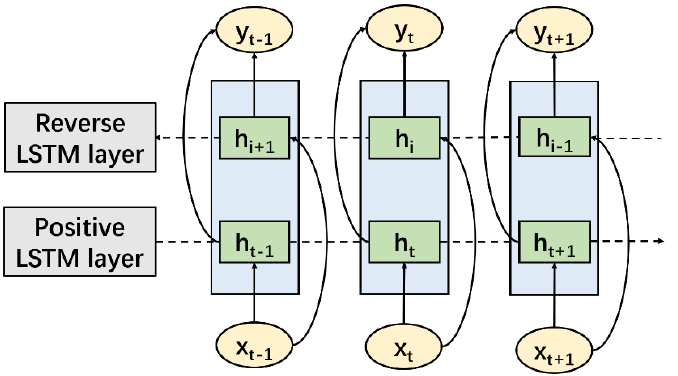
Figure 3. Functional diagram of BiLSTM.